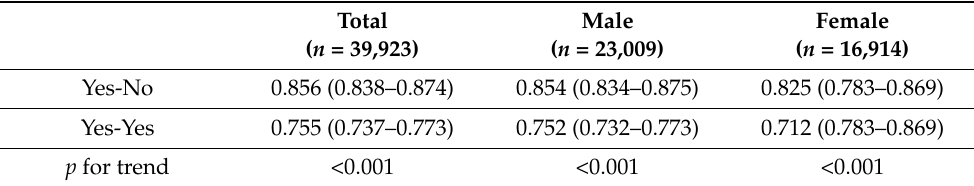
Table 5. Association of NT-proBNP with fatty liver and HOMA-IR score, accounting for obesity. Table 5. Cont .